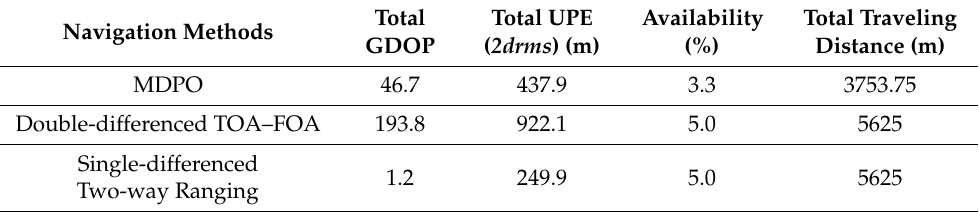
Table 13. The numerical simulation results with increased receiver observation errors and signal processing delay time uncertainty: σ ω r = 2.0 m, σ ω d = 1.0 Hz, the magnitude of ω process is 200.0 ns, and the magnitude of c process is 200.0